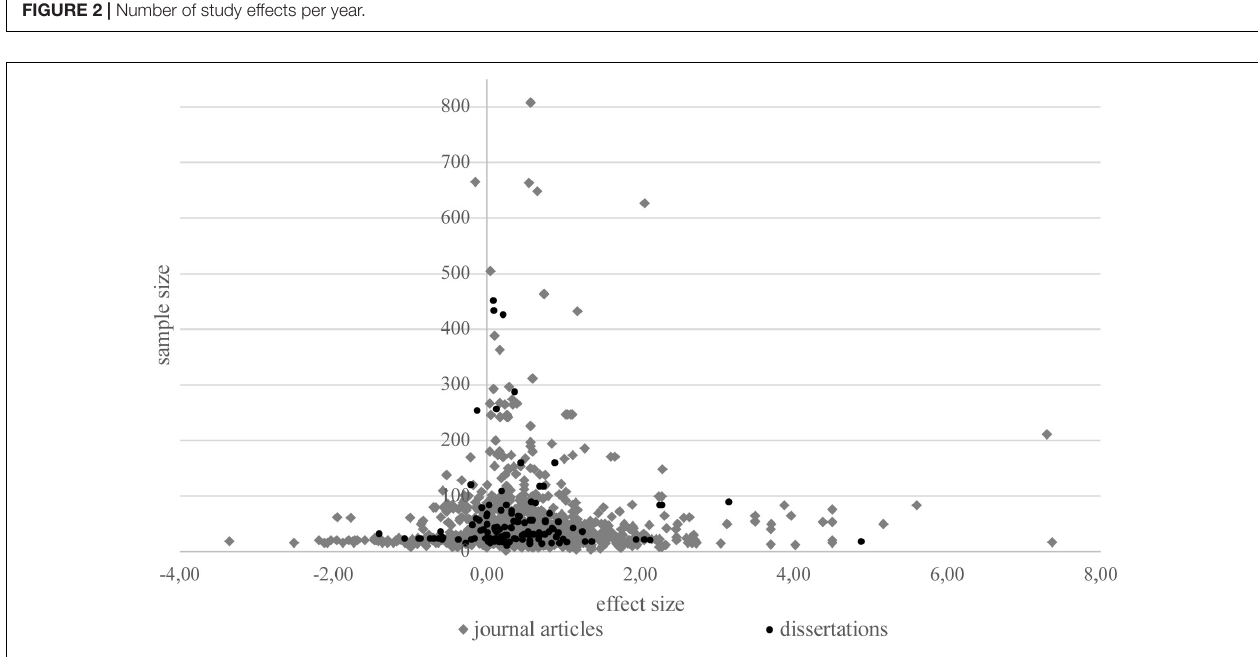
FIGURE 2 | Number of study effects per year.